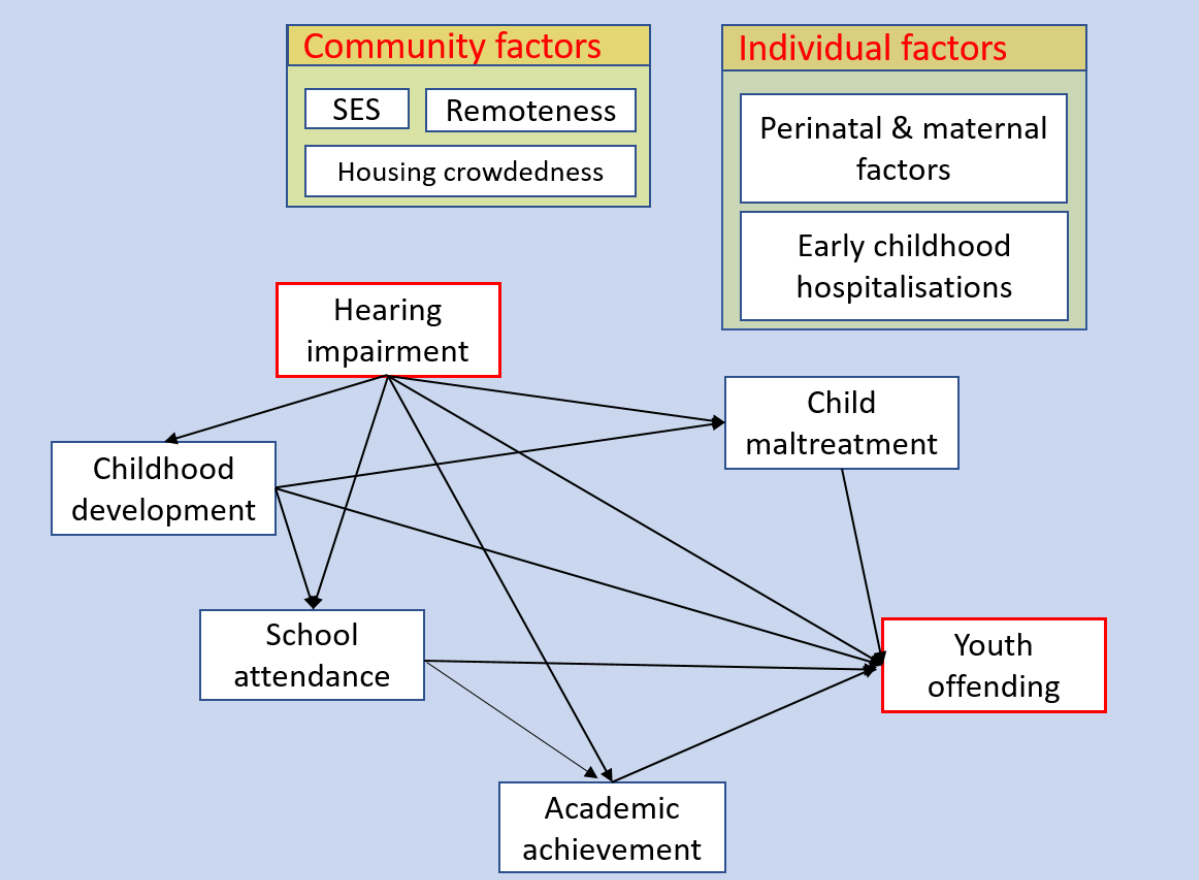
Figure 1. Conceptual diagram indicating the pathways of influence of hearing impairment on life trajectories and the interplay between them (SES: socioeconomic